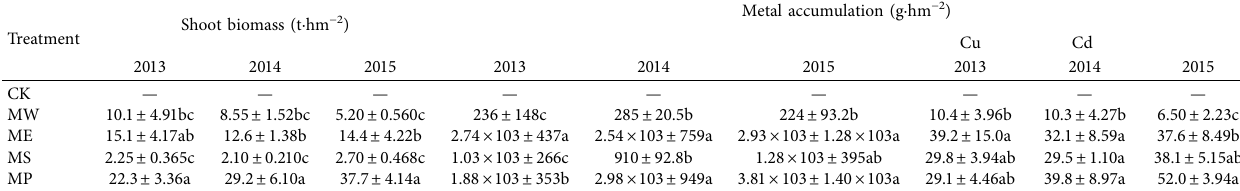
Table 3: Shoot biomass and Cu and Cd accumulation in each plant during phytoextraction.